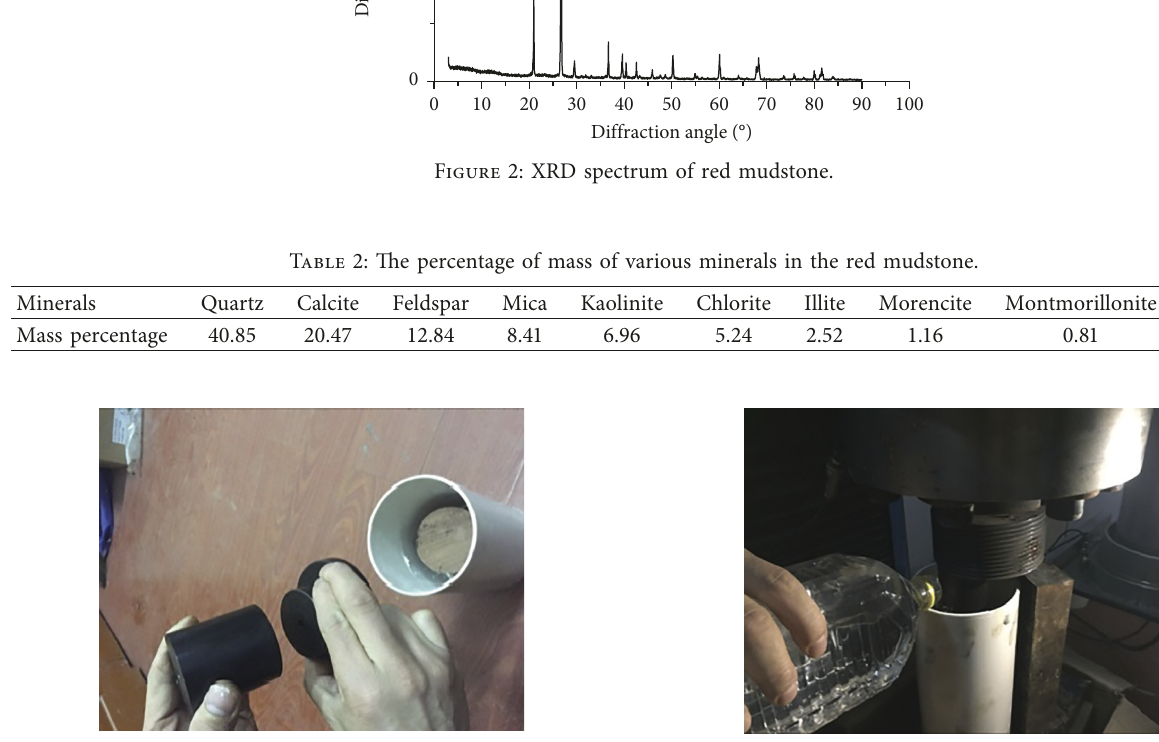
Figure 3: Installation of test equipment. Figure 4: Hydration of dry red mudstone with water